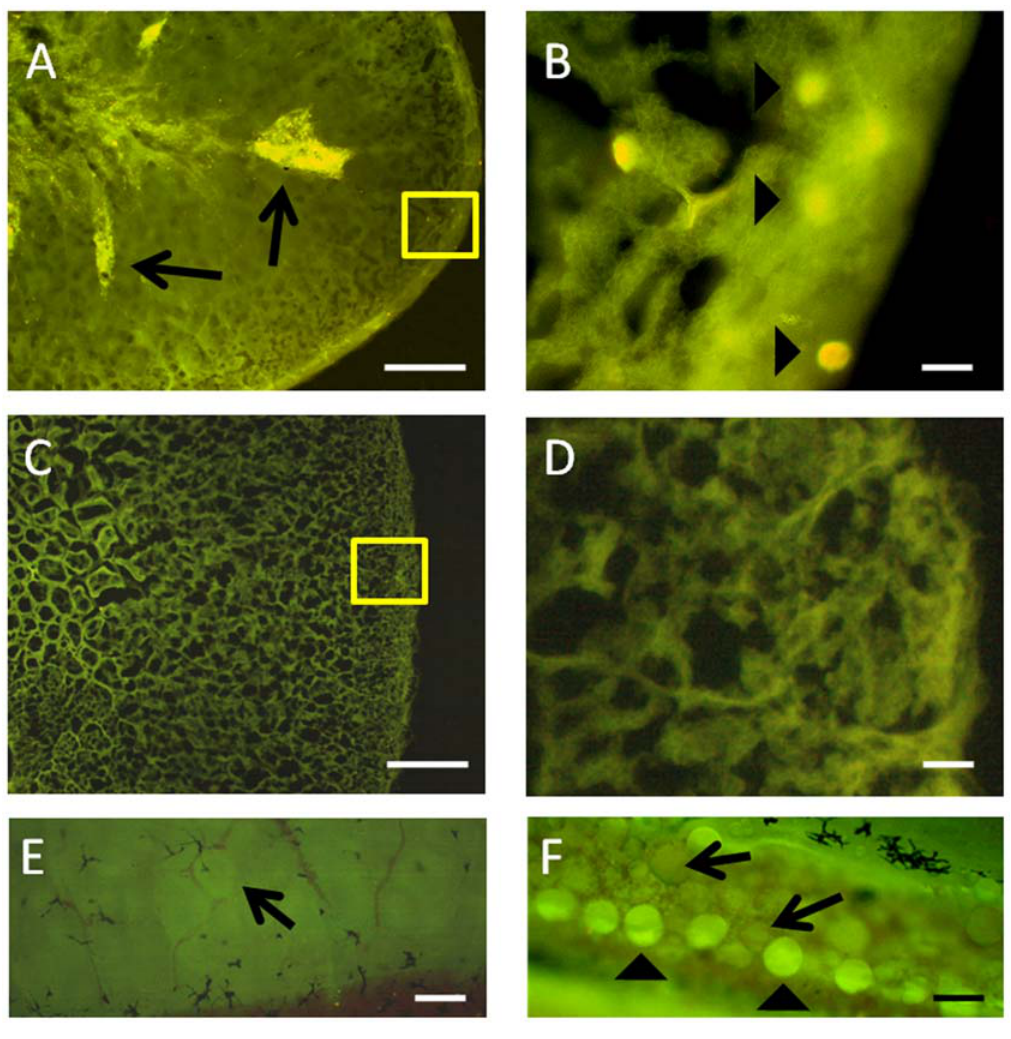
Figure 1. Distribution of CFDA-SE-labeled (2 m M/10 min RT) donor germ cells in recipient gonads 4–6 weeks after transplantation. A,B) Four weeks after transplantation, the donor germ cells were found distributed throughout the seminiferous lobules (arrows) and a small number, presumably spermatogonia, have reached the blind end of the seminiferous lobules (arrowheads; B is a high magnification of the box in A). C,D) Corresponding control sections from non-transplanted gonads (D is a high magnification of the box in C) showing the absence of fluorescent cells. E) Whole-mount preparation of a non-transplanted control gonad showing a cyst of spermatogonia near the blind end of the seminiferous lobule (arrow). F) Whole-mount preparation of a gonad from a transplanted animal six weeks after transplantation showing that donor-derived spermatogonia (arrowheads) have undergone proliferation along with endogenous (arrows) cells in the blind end of the seminiferous lobules of recipient gonads. Scale bars indicate 100 m m (A, C) and 20 m m (B, D, E and